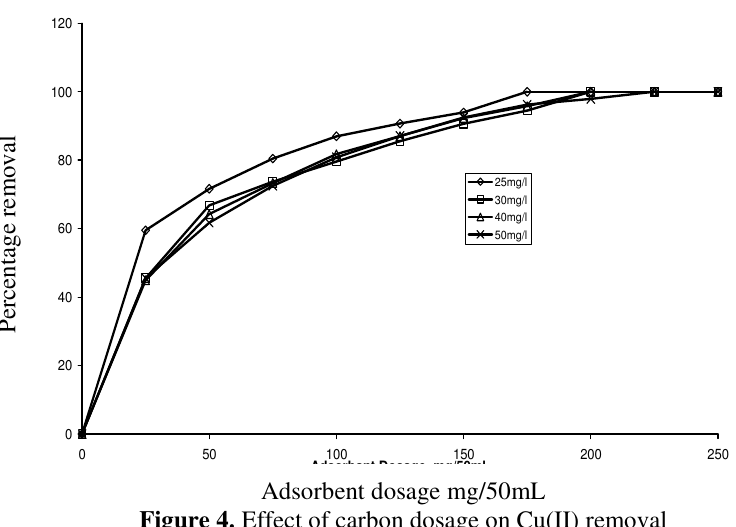
Figure 4. Effect of carbon dosage on Cu(II) removal